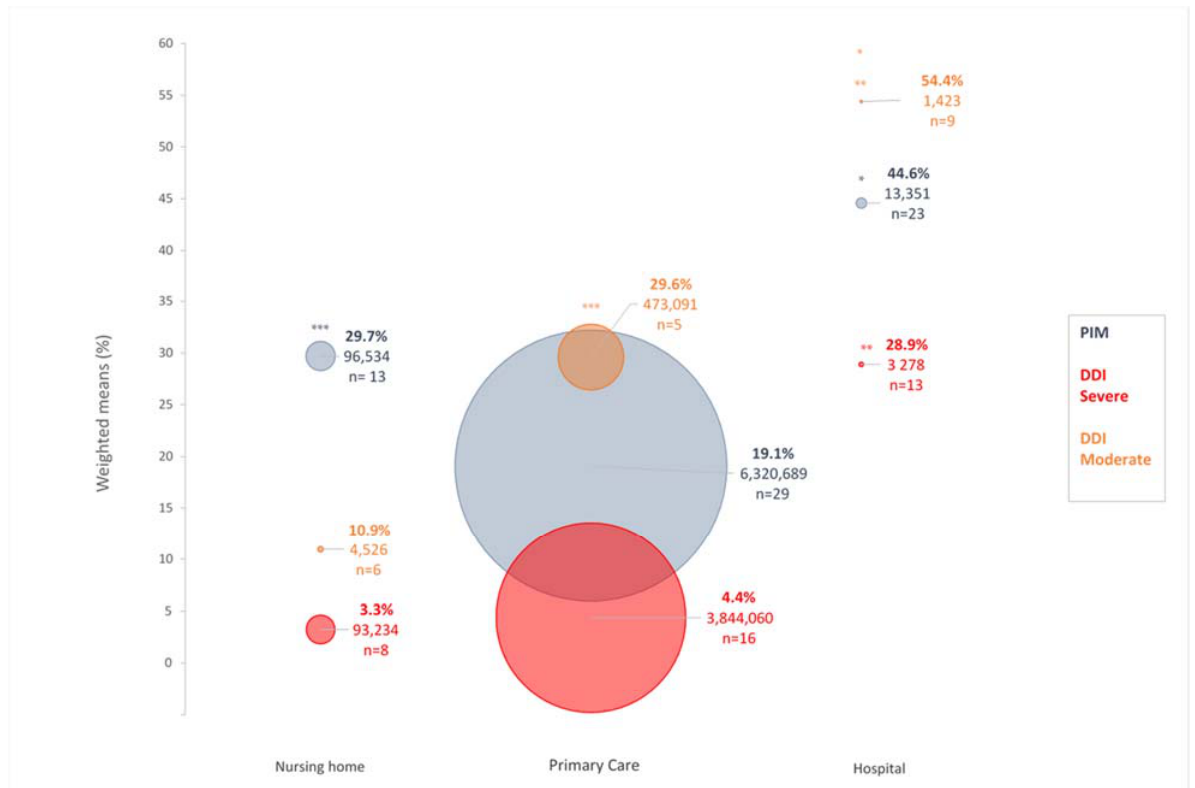
Figure 1. Bubble plot of the prevalence (%) of potentially inappropriate medication (PIM) (grey) and of severe (red) and moderate (orange) drug–drug interaction (DDI) in elderly patients in primary care, nursing home and hospital settings. The prevalence of both PIM and DDI has been reported as a weighed mean. The surface of the circle is proportional to the total sample size of the studies used in the calculation of the parameters (the sample size, the weighed mean and the number of studies used are reported). *: significant difference between hospital and primary care settings. **: significant difference between hospital and nursing home settings. ***: significant difference between primary care and nursing home settings.